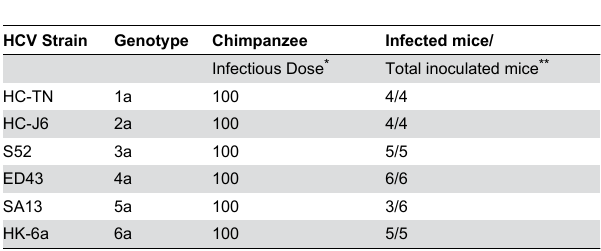
Table 2. MUP-uPA/SCID/Bg mice infected with different HCV genotypes.